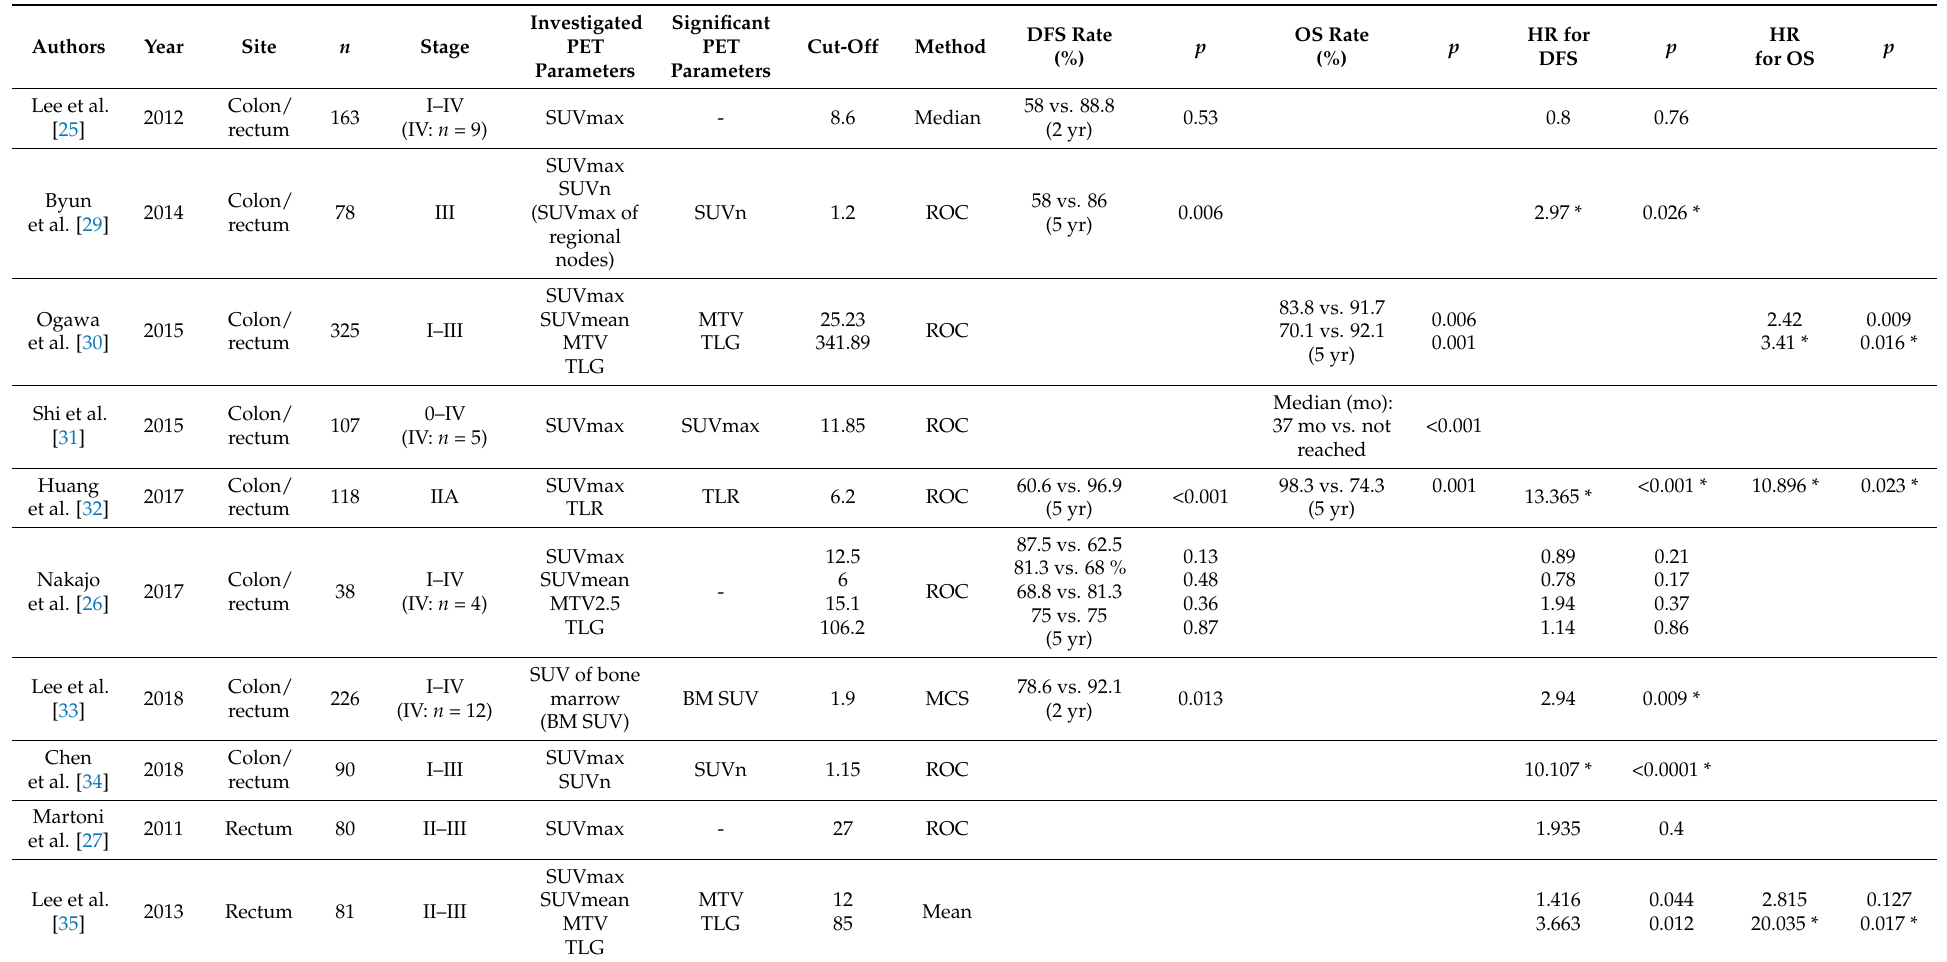
Table 4. Previous studies on metabolic parameters from the pretreatment 18 F-FDG PET/CT of non-metastatic resectable colorectal